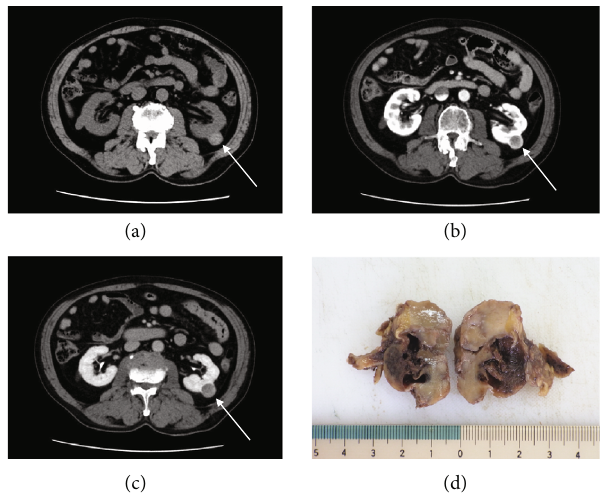
Figure 1: (a) Plain CT: tumor showed slightly dense signal (white arrow). (b) Contrast-enhanced CT: well-de fi ned solid mass was enhanced around the tumor in the early phase (white arrow). (c) Contrast-enhanced CT: tumor was washed out in the late phase (white arrow). (d) Cut surface of the tumor. cystic area was observed inside the